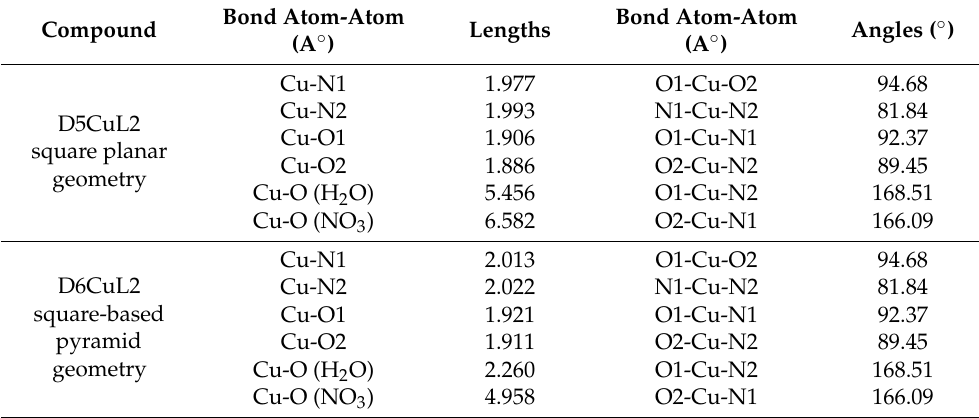
Table 4. Selected bond lengths (Å) and angles ( ◦ ) for compounds D5CuL2 and